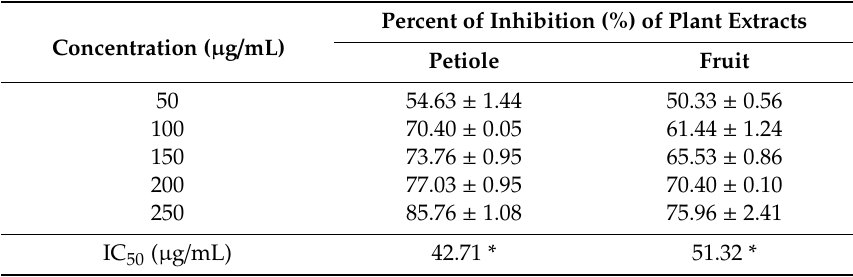
Table 2. Xanthine oxidase inhibitory activity of ethanolic petiole and fruit extract of A. longiloba.